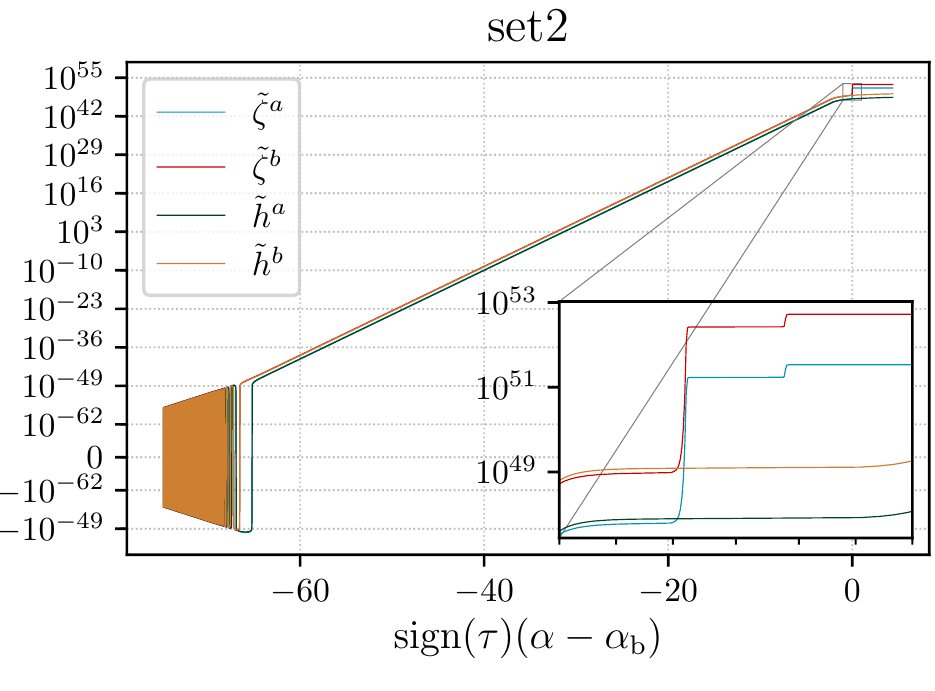
Figure 9. Evolution of scalar and tensor perturbations in the background of case B. Scalar and tensor perturbations grow almost at the same rate during classical contraction, but at the quantum bounce the scalar perturbations are enormously enhanced over the tensor perturbations due to the quantum effects (shown in the detail of the figure). After the bounce, the perturbations get frozen. The final amplitudes of both perturbations are compatible with observations. The indices a and b refer to the real and imaginary parts of the perturbation